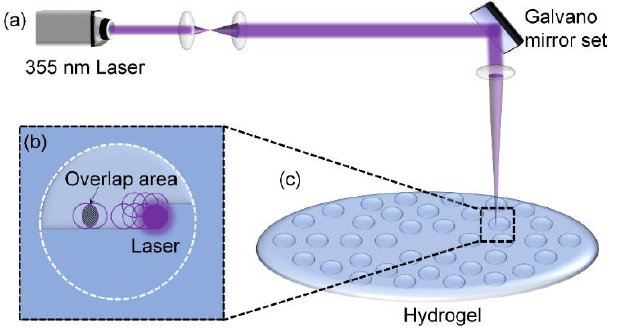
Table 1. Process parameters for laser-based fabrication of hydrogel surface micro-pits.